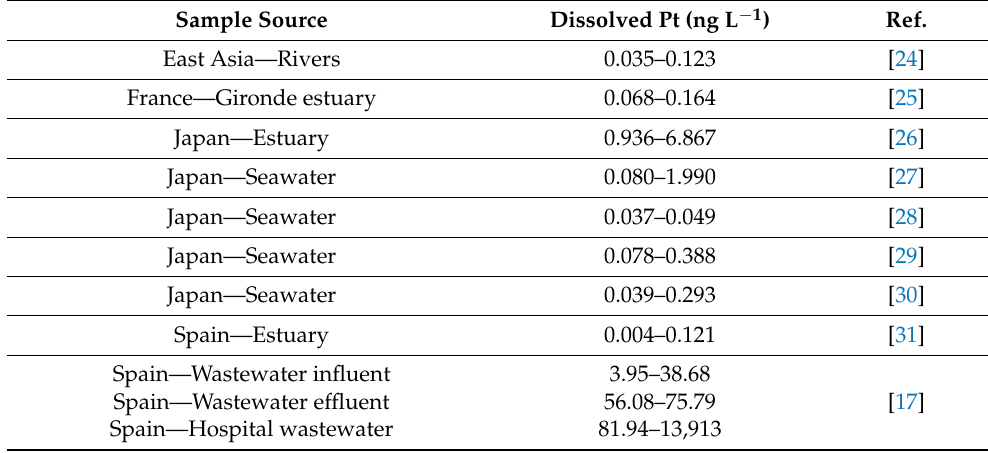
Table 1. Previously reported d-Pt concentrations in environmental and wastewater